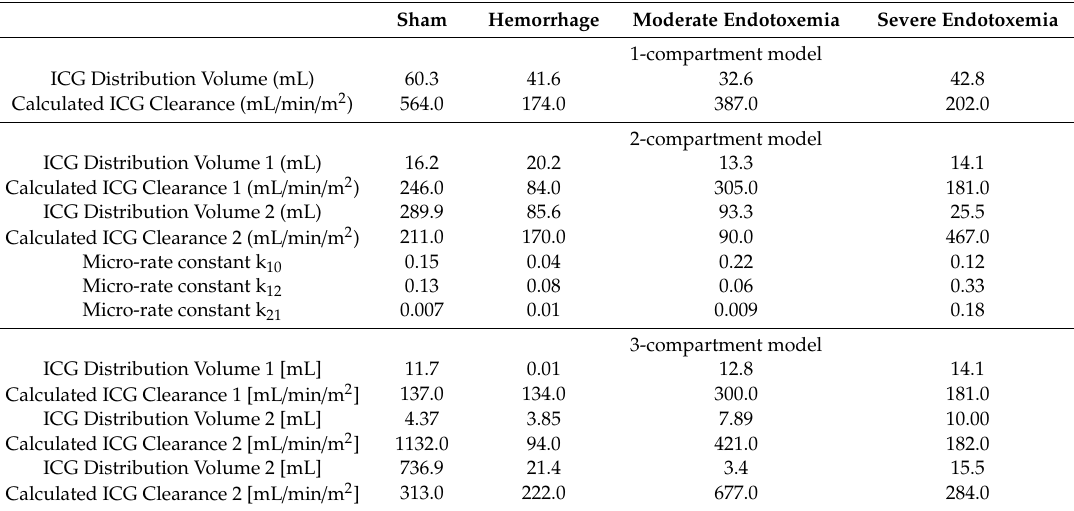
Table 2. Calculation of compartment models in di ff erent shock conditions.